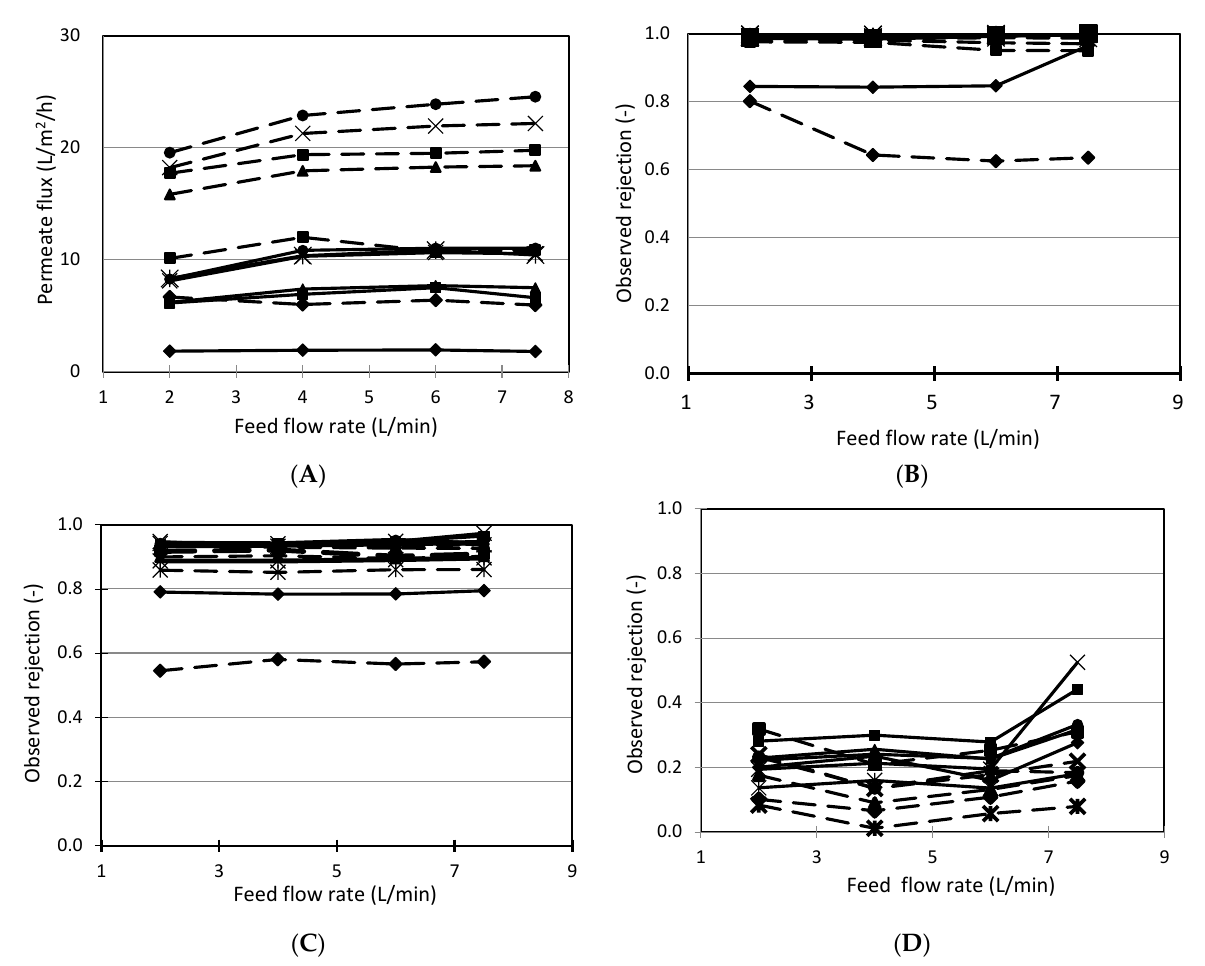
Figure 2. Effect of feed flow rate on nanofiltration of cranberry juice. Solid line: fresh cranberry juice, dashed line: UF cranberry juice. ( A ): permeate flux, ( B ): sugar rejection, ( C ): organic acid rejection, ( D ): benzoic acid rejection. The conditions of nanofiltration: operating pressure: 3 MPa, operating temperature: 25 °C, pH: 2.5. ▲ : NTR7250, : UTC 60, : G5, : DRA 4510, : NF99, : Desal DK.